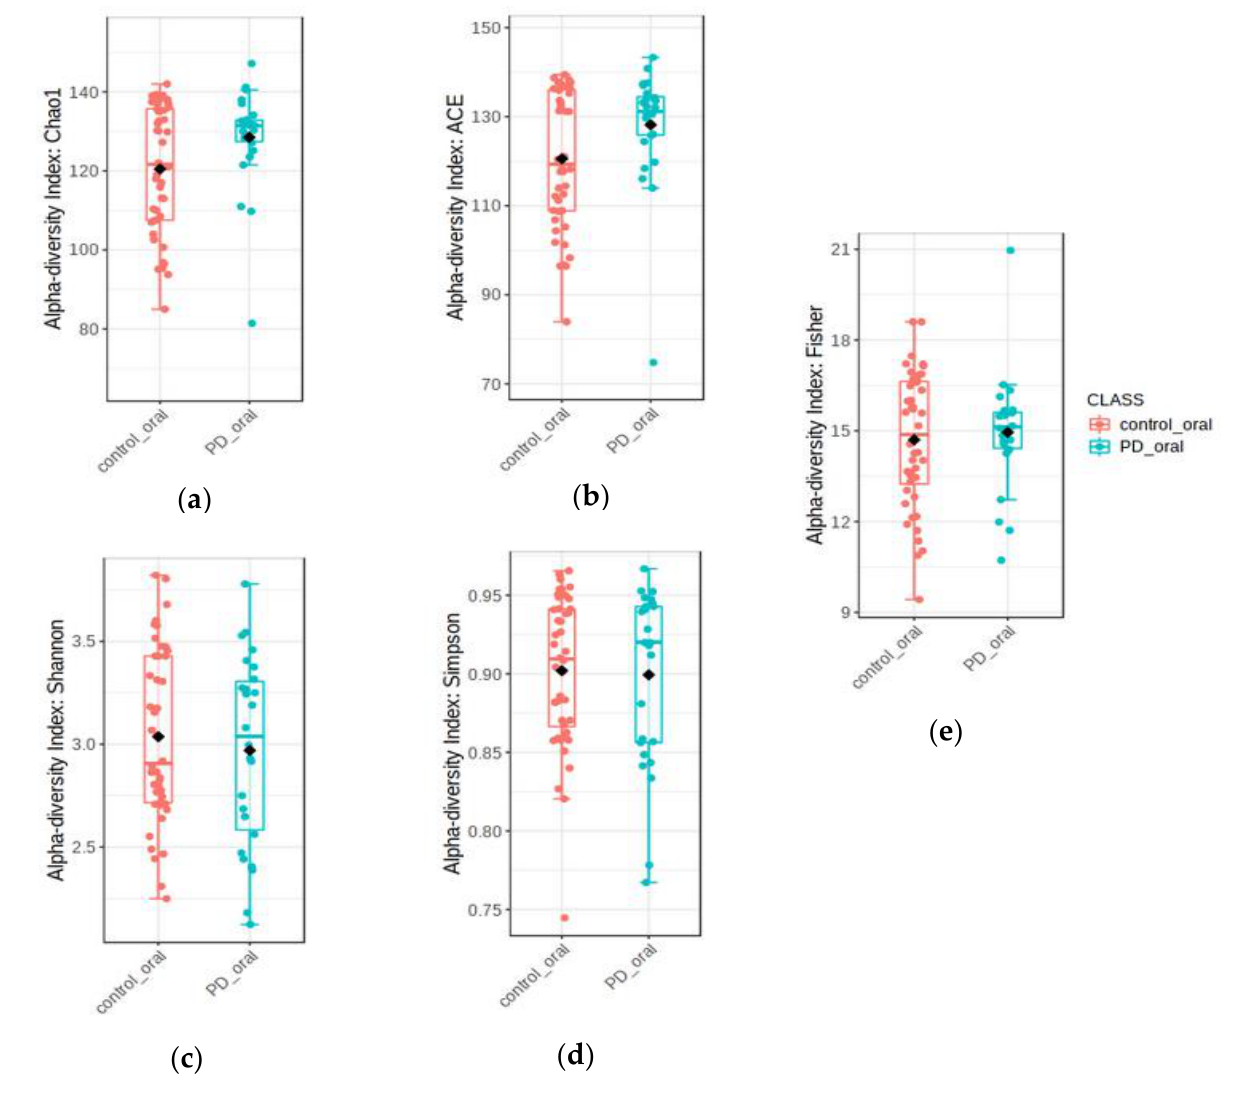
Figure 2. Comparisons of different alpha-diversity indices in patients with PD (PDG) and healthy controls (CG). ( a ) Chao1, p -value: p < 0.02 between PDG and CS. ( b ) ACE p < 0.03 between PDG and CG. ( c ) Shannon diversity index ( p < 0.55) among patients with PD with different severity. ( d ) Simpson diversity index ( p < 0.84) among patients with PD with different severity. ( e ) Fisher diversity index ( p < 0.62) among patients with PD with different severity.